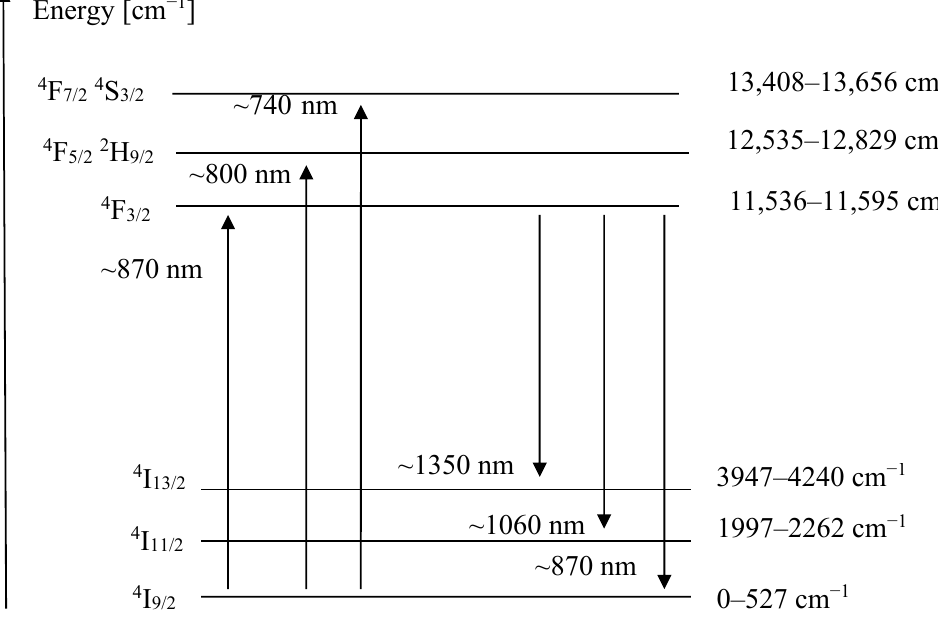
Figure 1. Partial energy level diagram of Nd:YLF Fig. 1. Partial energy level diagram of Nd:YLF crystal from [9].